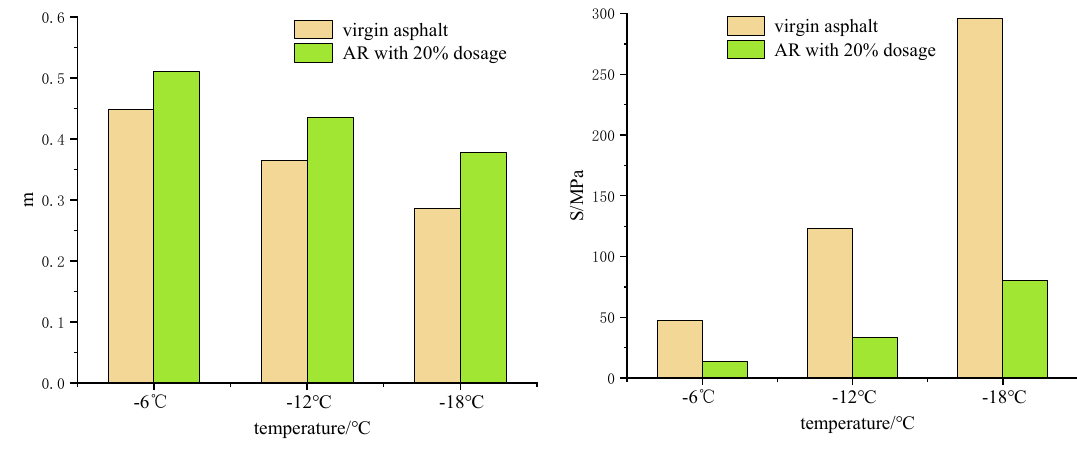
Figure 8. Creep S and m of asphalt rubber.